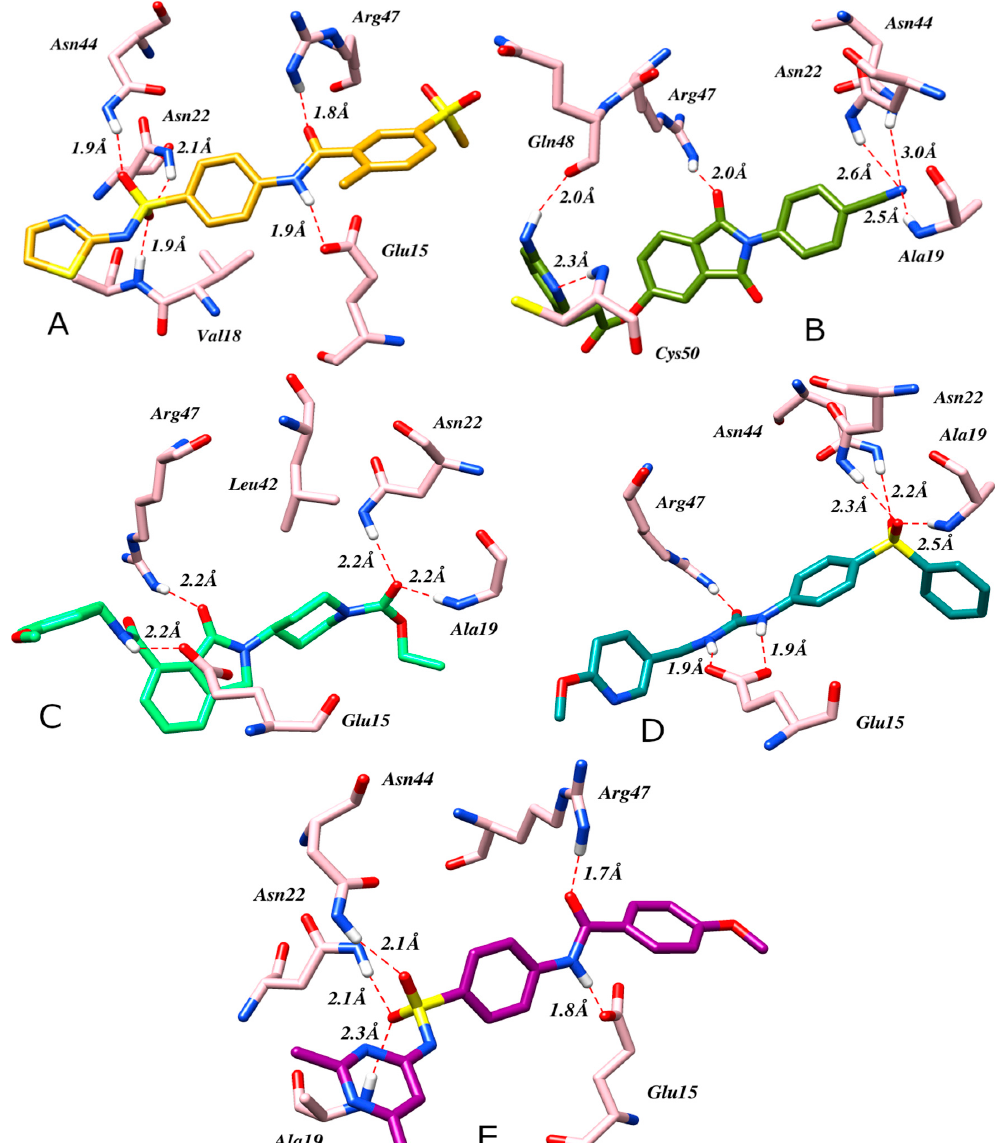
Figure 3. 3D model showing interaction of compound CHEMBL1881008 ( A ), CHEMBL1173124 ( B ), CHEMBL1438901 ( C ), CHEMBL2393181 ( D ), and CHEMBL1461227 ( E